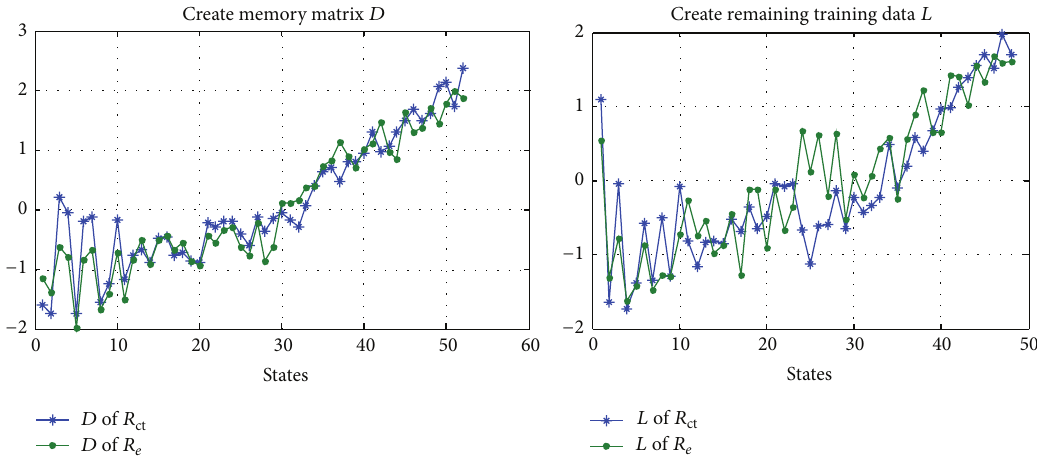
Figure 12: Construction of memory matrix 𝐷 and the remaining training data 𝐿 of 𝑅 𝑒 and 𝑅